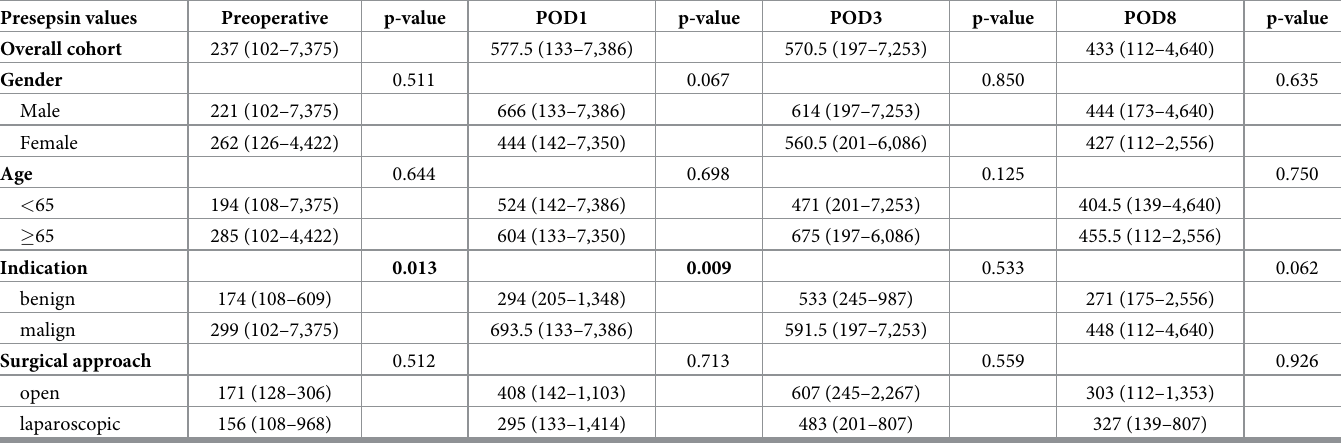
Table 2. Presepsin values stratified by gender, age, indication for PR and surgical approach. Presepsin